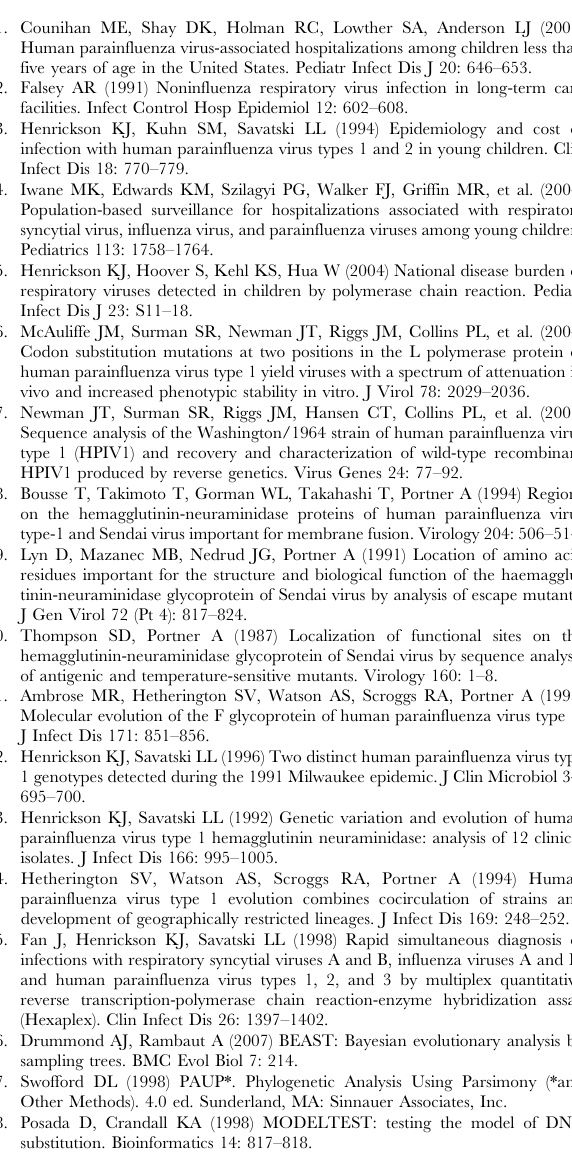
Figure S6 Phylogenetic relationship of HPIV-1 HN gene using sequences from the current study only with the maximum likelihood method in PAUP. Figure S7 Phylogenetic relationship of HPIV-1 HN gene including 221 sequences from GenBank with the maxi- mum likelihood method in PAUP. (TIFF) Figure S8 Phylogenetic relationship of HPIV-1 L gene including two sequences from GenBank with the max- imum likelihood method in PAUP. The accession nos. of the two GenBank sequences are: AF117818 and AF457102.